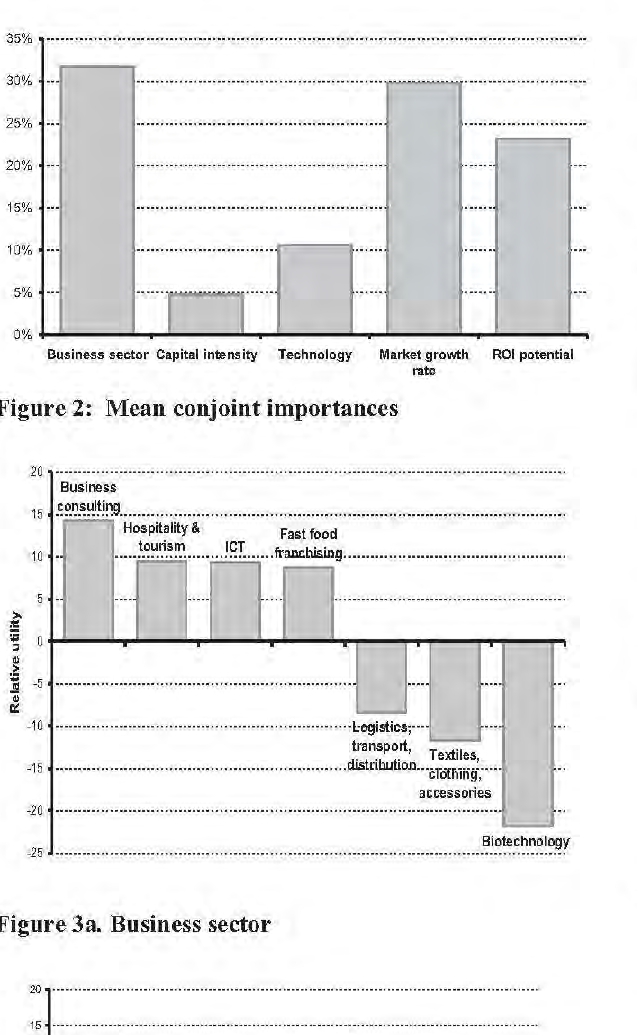
Figure 3a. Business sector